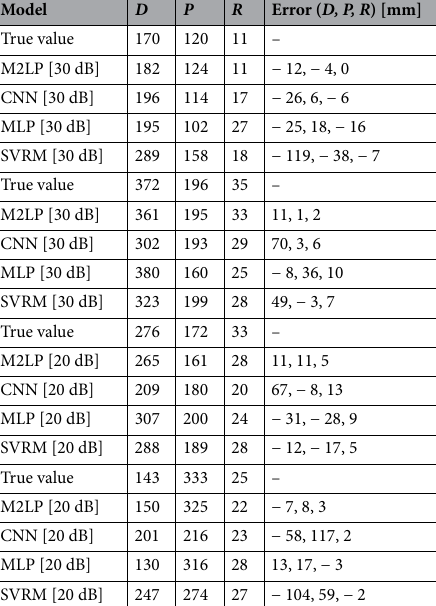
Table 10. Predicted characteristic parameters of the buried object versus true values for selected test scenarios.